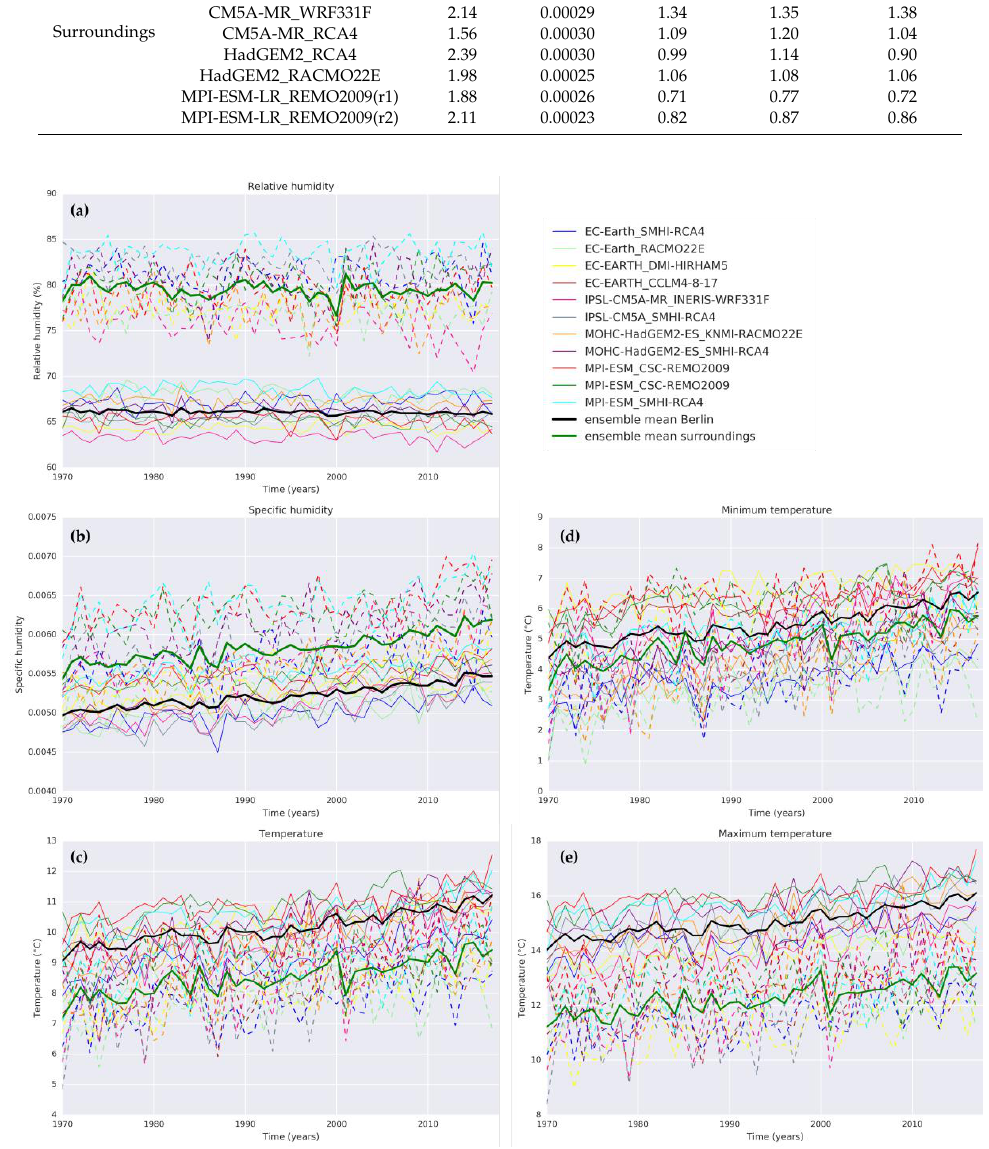
Figure A2. Yearly mean for each model of the EURO-CORDEX multi-model ensemble compared to the multi-model mean for 1970–2017. The variables presented are ( a ) relative humidity, ( b ) specific humidity, ( c ) temperature, ( d ) minimum temperature, and ( e ) maximum temperature.